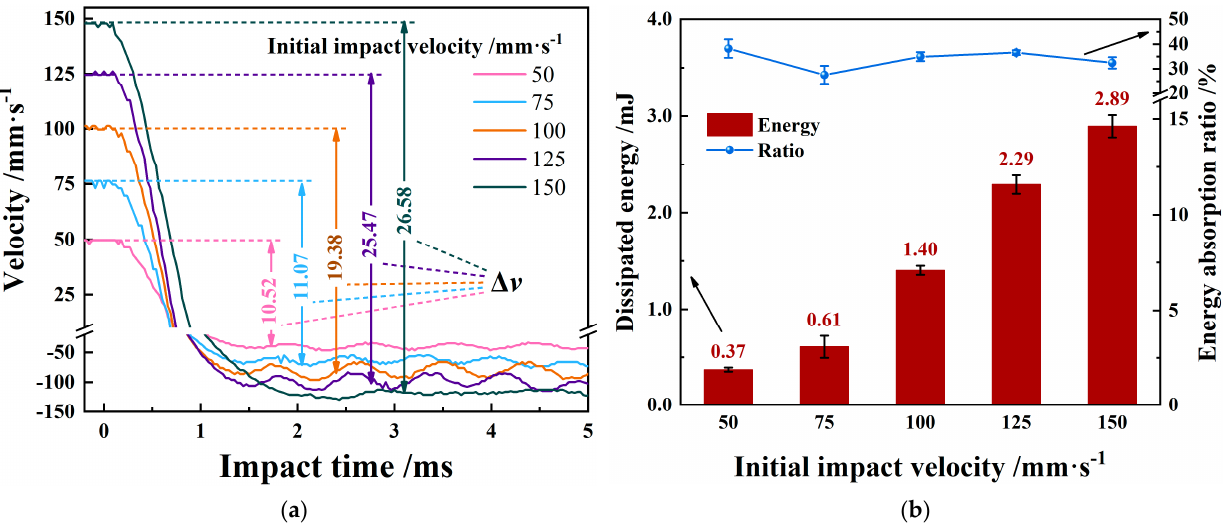
Figure 3. Dynamic response of velocity and dissipated energy with varying initial impact velocities. ( a ) Impact velocity response vs. time; ( b ) absorbed energy evolution.